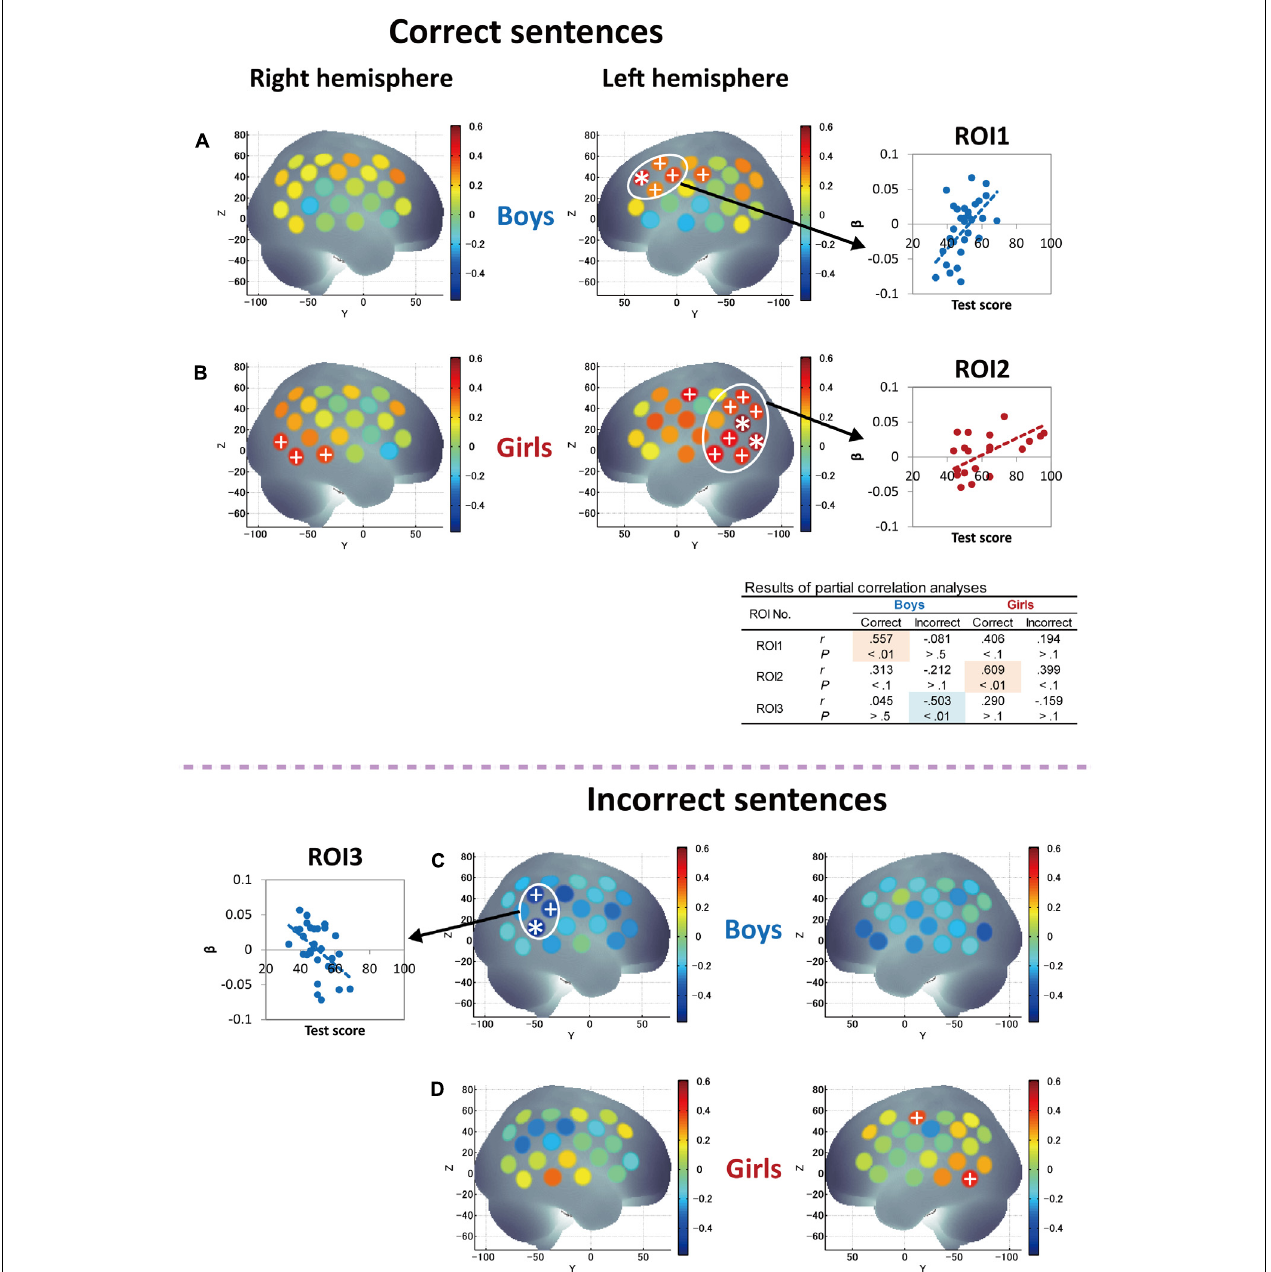
FIGURE 6 | Results of partial correlation analyses between grammar listening test score and cortical activation during correct-sentence processing [boys (A) and girls (B) ] and incorrect-sentence processing [boys (C) and girls (D) ] with RST score (WM capacity) as a control variable. Colored bars represent partial correlation coefficient. Asterisks and plus signs are the same as those in Figure 5 . In the table to the middle right side, statistical results of partial correlation analyses (partial correlation coefficients, r and P -values) are shown for each ROI so that the trends of similarities and/or differences in the relationships between Grammar_L scores and cortical activation can be compared between sexes, as well as between correct- and incorrect-sentence